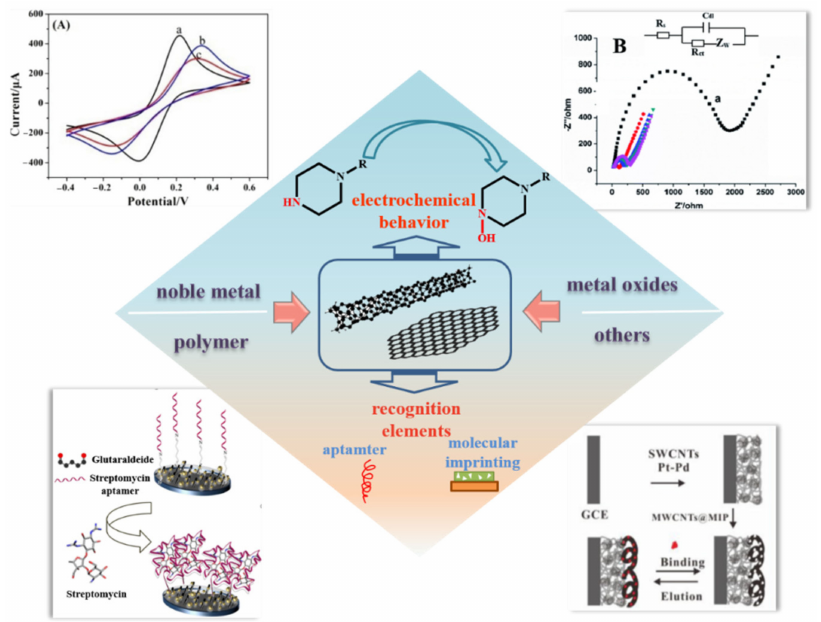
Figure 1. An overview of functional CNMs and their application in the detection of antibiotics.